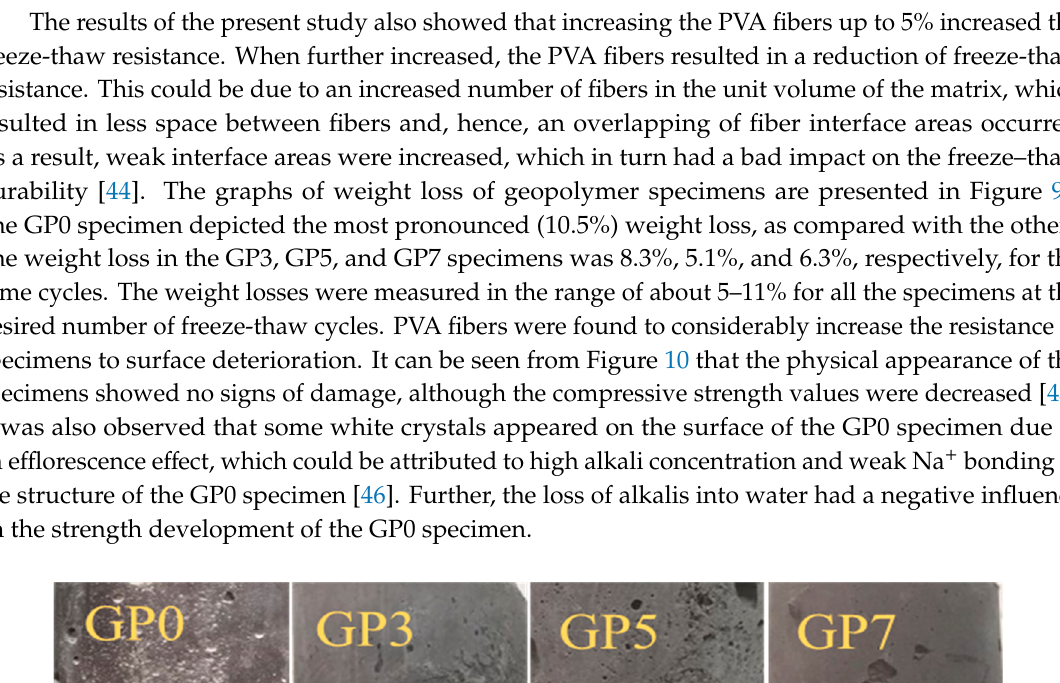
Figure 9. Freeze thaw resistance in terms of ( A ) % change in compressive strength; ( B ) % weight loss.